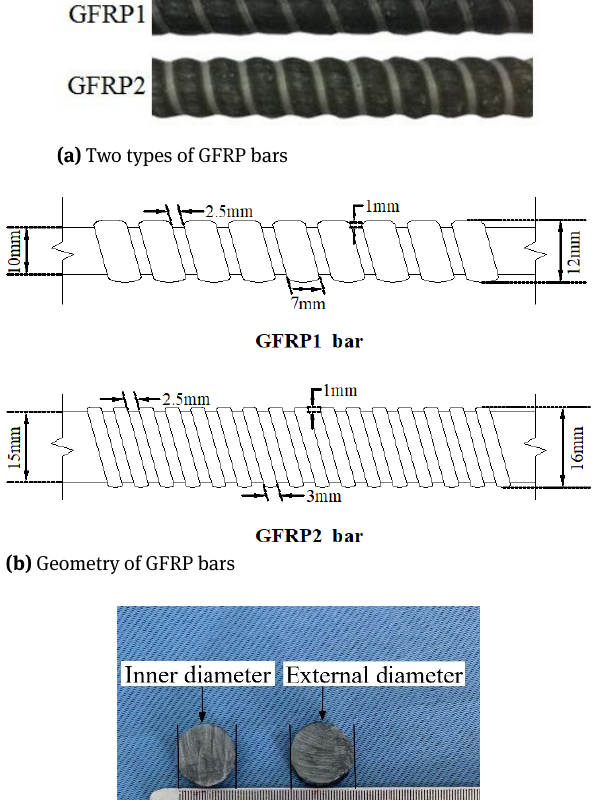
Table 1: Physical properties of GFRP